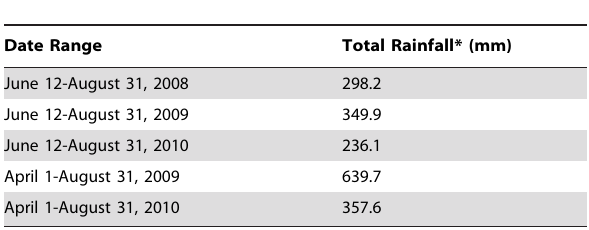
Table 2. Rainfall recorded at green roof